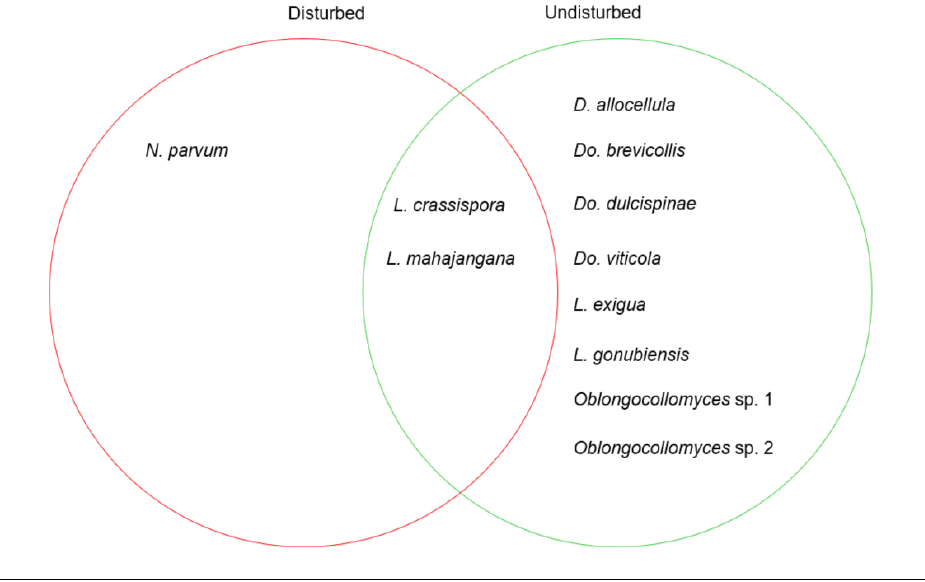
Figure 7. Venn diagram indicating species diversity and distribution of the Botryosphaeriaceae on tree species of the Anacardiaceae in disturbed (including S. birrea and M. indica at Tshikundamalema and Tshipise) and undisturbed (including S. birrea and L. schweinfurthii at Nwanedi, Mapungubwe and Kruger National Park) ecosystems.